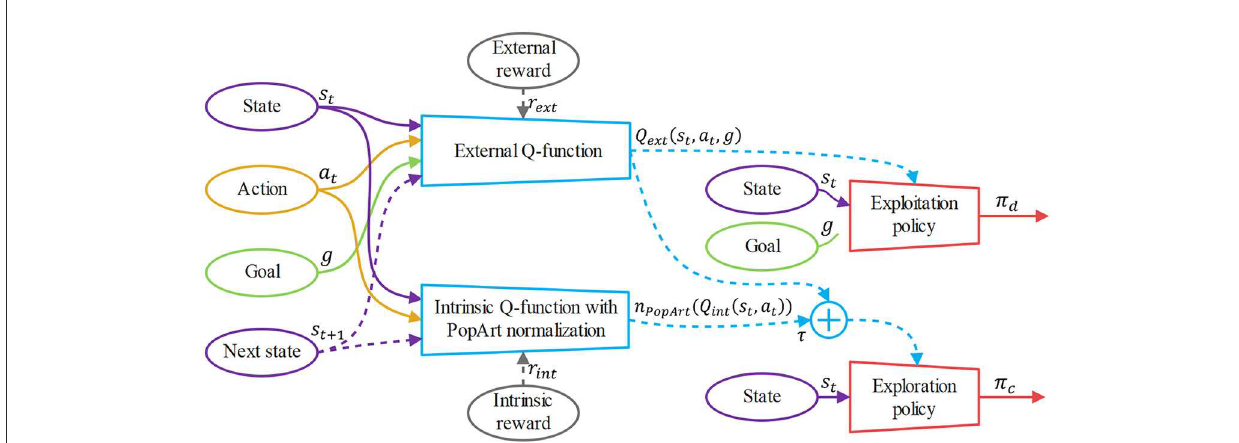
FIGURE3 The overview of our hybrid policy architecture. The solid arrows show the inputs and outputs of the Q-functions and policies, while the dotted arrows show the additional sources used for the updates of the Q-functions and policies. The external Q-function and the intrinsic Q-function are updated by the Bellman bootstrapping with r ext and r int , respectively. After the intrinsic Q-function is PopArt-normalized, the exploitation policy π d is updated by the gradient ascent of Q ext ( s t , a t , g ) and the exploration policy π c is updated by the gradient ascent of Q ext ( s t , a t , g ) + τ · n PopArt ( Q int ( s t , a t ) ).